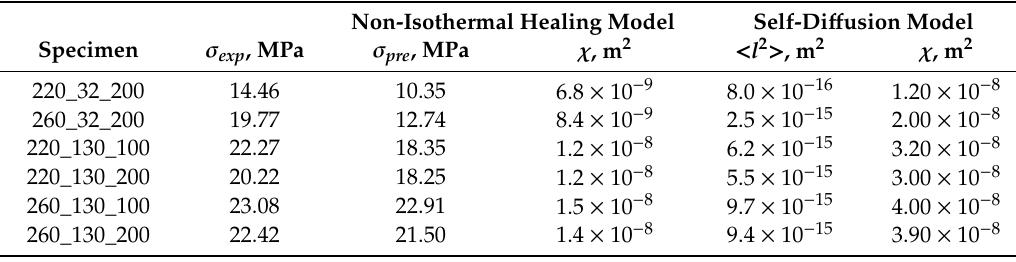
Comparison between the predictions of the non-isothermal healing model and self-di ff usion